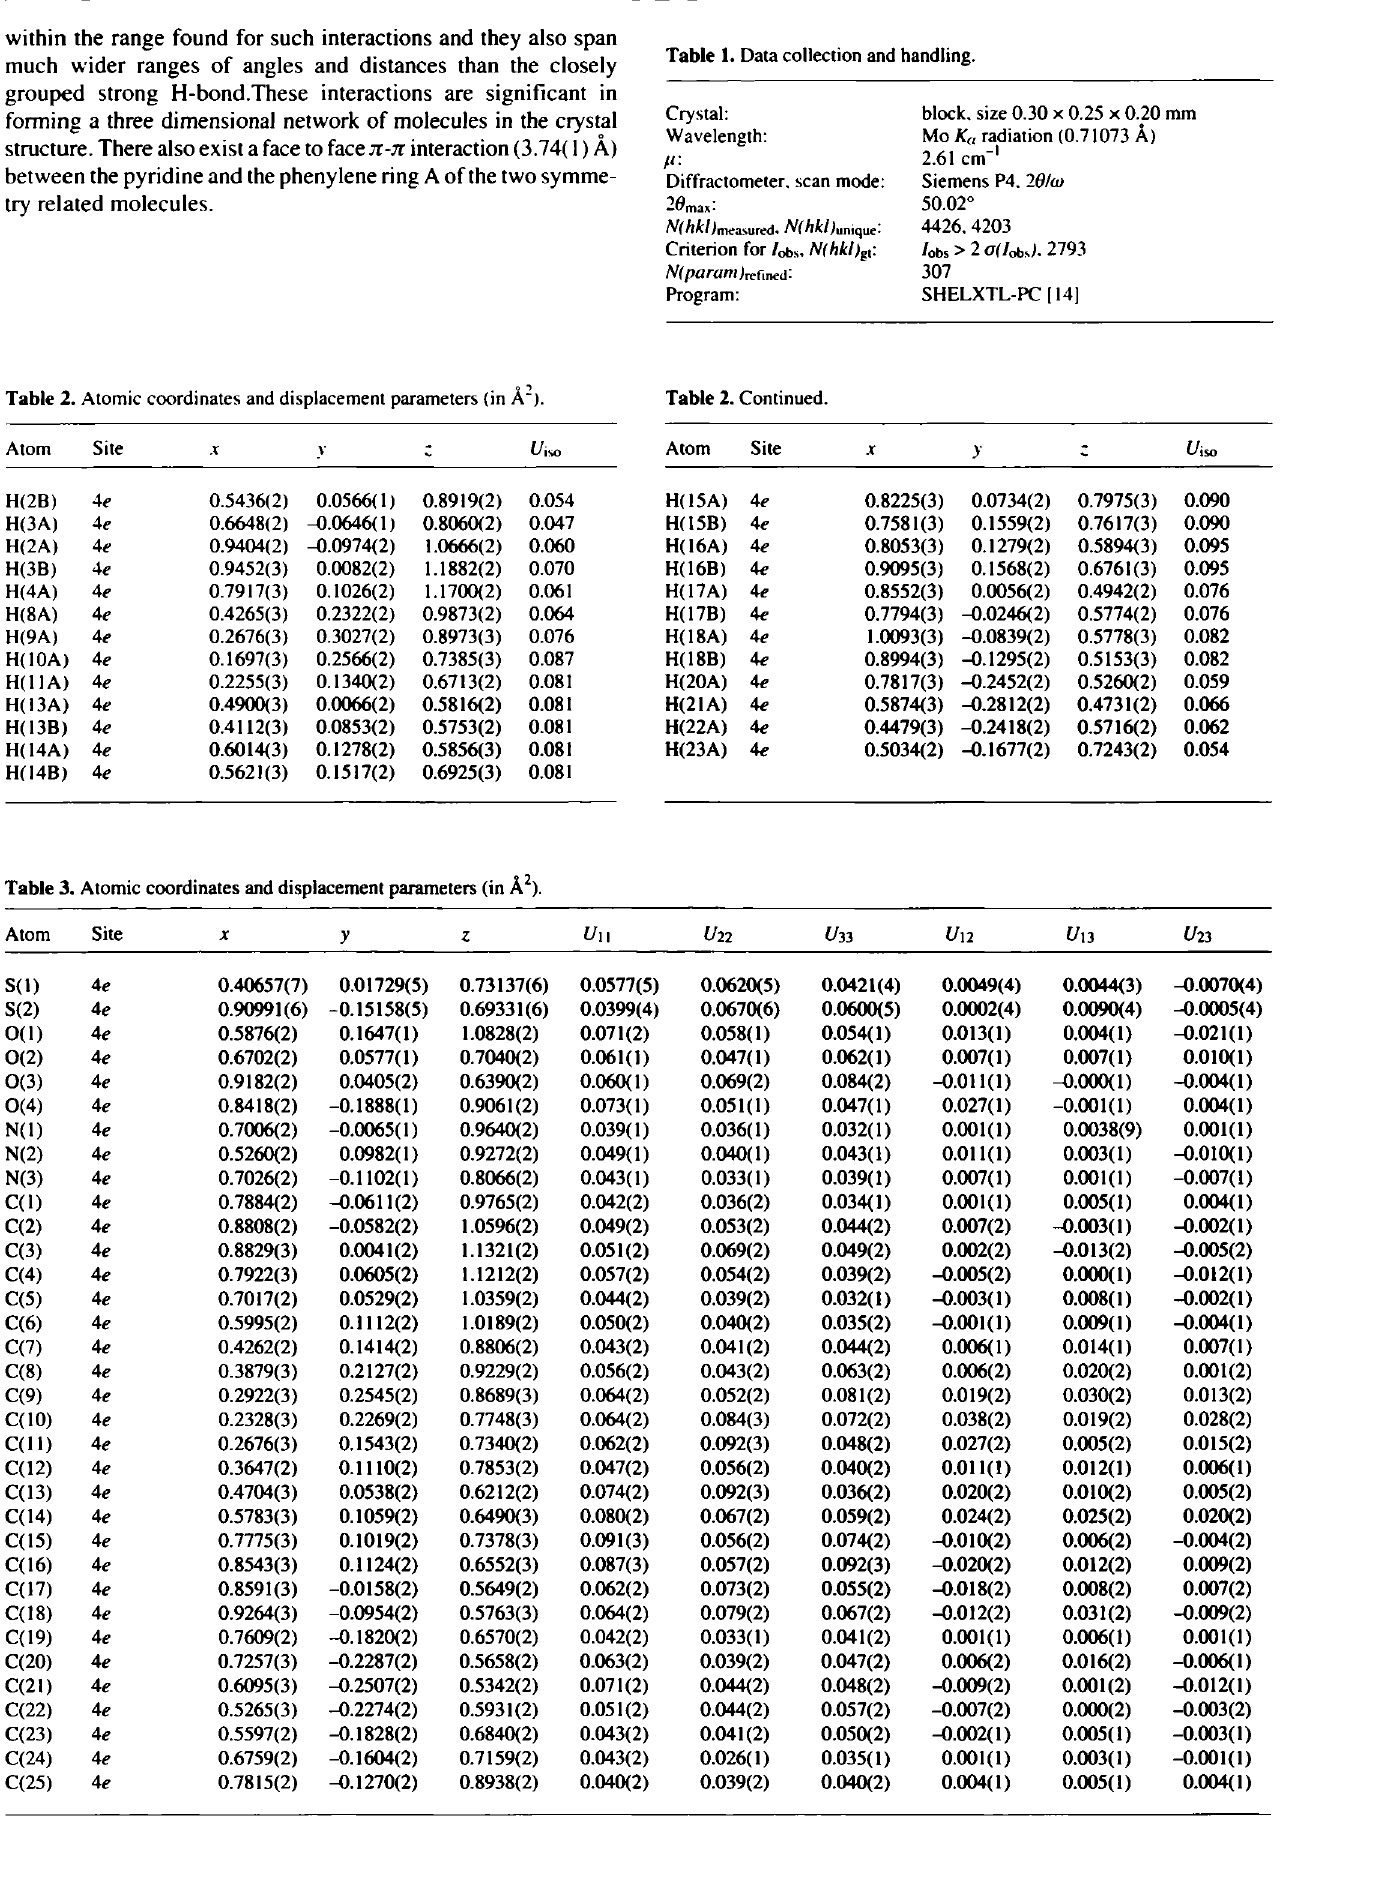
Table 1. Data collection and handling.